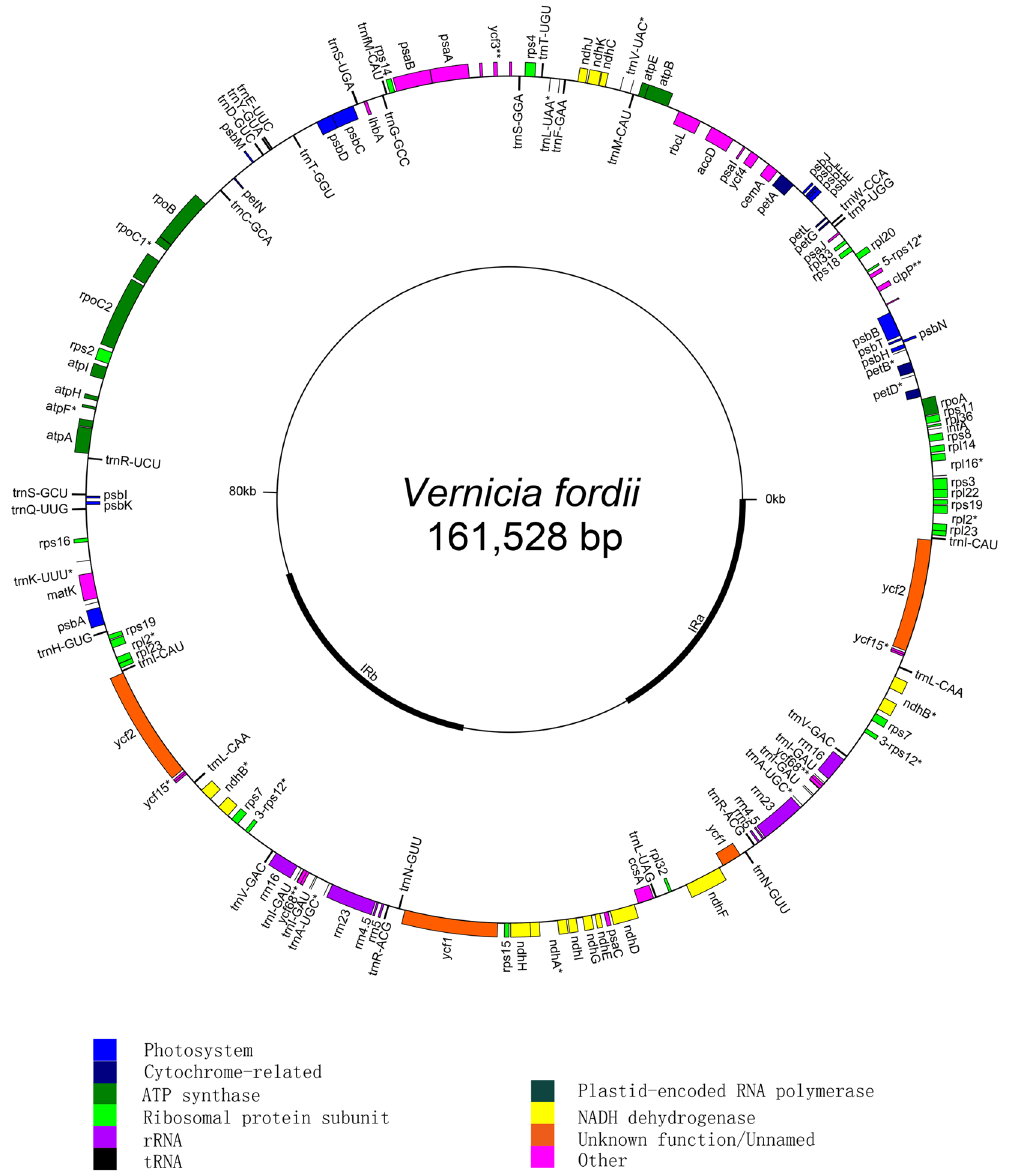
Figure 1. Gene map of tung tree chloroplast genome from PacBio RS II platform. The thick lines indicate the inverted repeats (IRa and IRb) which separate the genome into large single copy (LSC) and small single copy (SSC) regions. Genes shown in the inner side of the circle are transcribed clockwise, and those located on the outside of the circle are transcribed